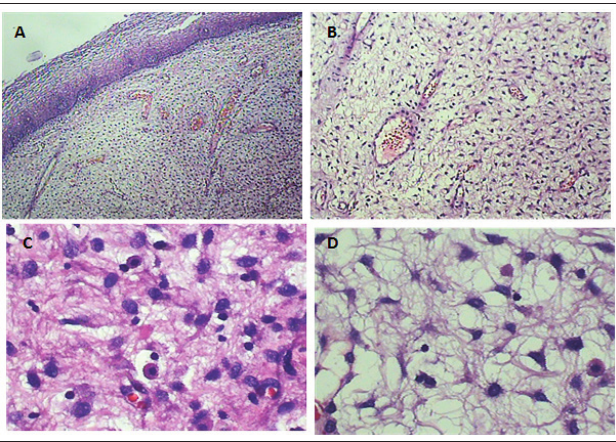
FigurE 1 − AAM in HE staining revealing a fragment of squamous mucosa with spindle- cell neoplastic proliferation in loose collagenous stroma with a myxoid matrix embedding irregular vessels and inflammatory cells. A) 40×; B) 100×; C) 400×; D) 400× AAM: aggressive angiomyxoma; HE: hematoxylin and eosin.